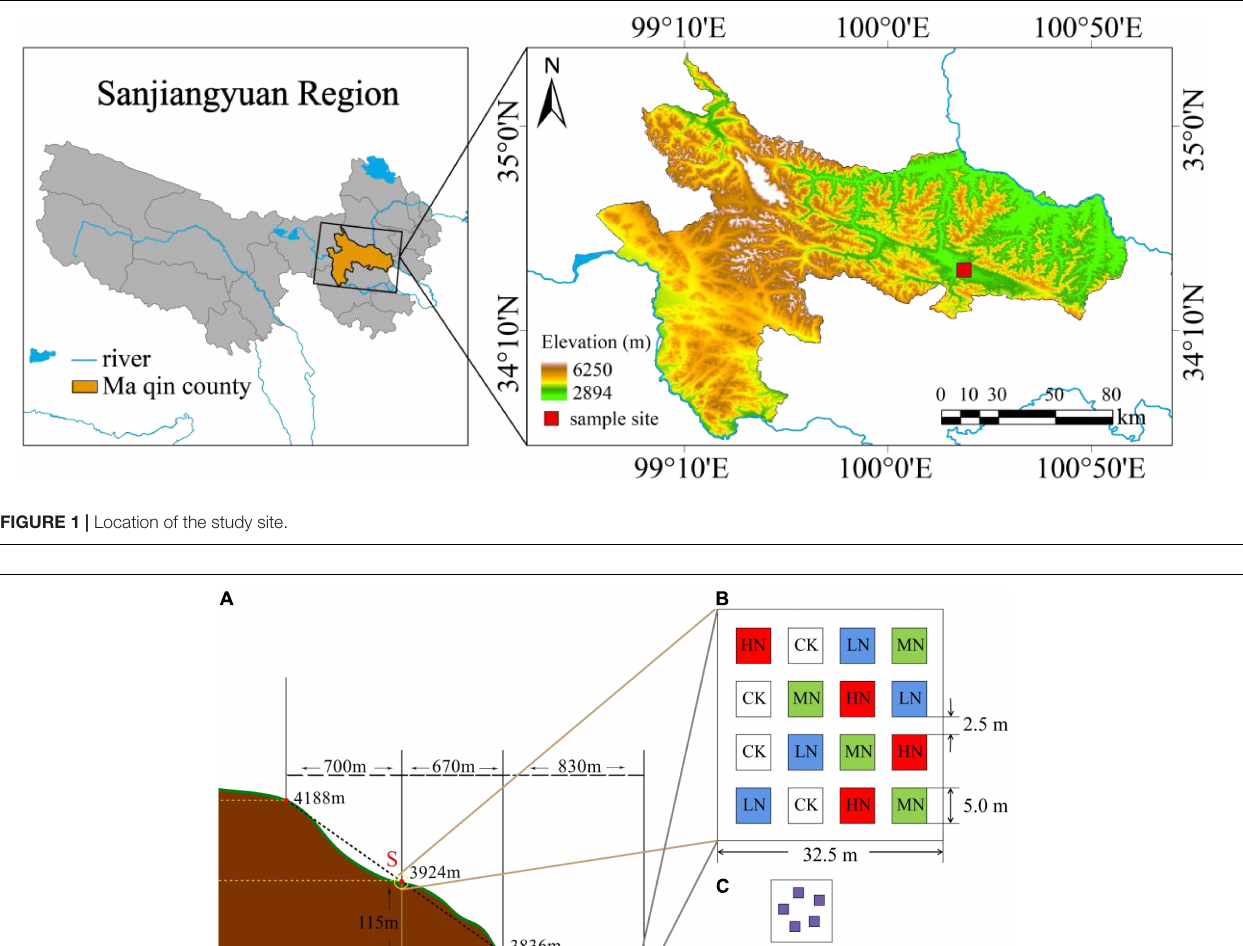
FIGURE 2 | (A) The distribution of gentle slope area and steep slope area. (B) The distribution of fertilization plots. (C) Sampling sites in each block.